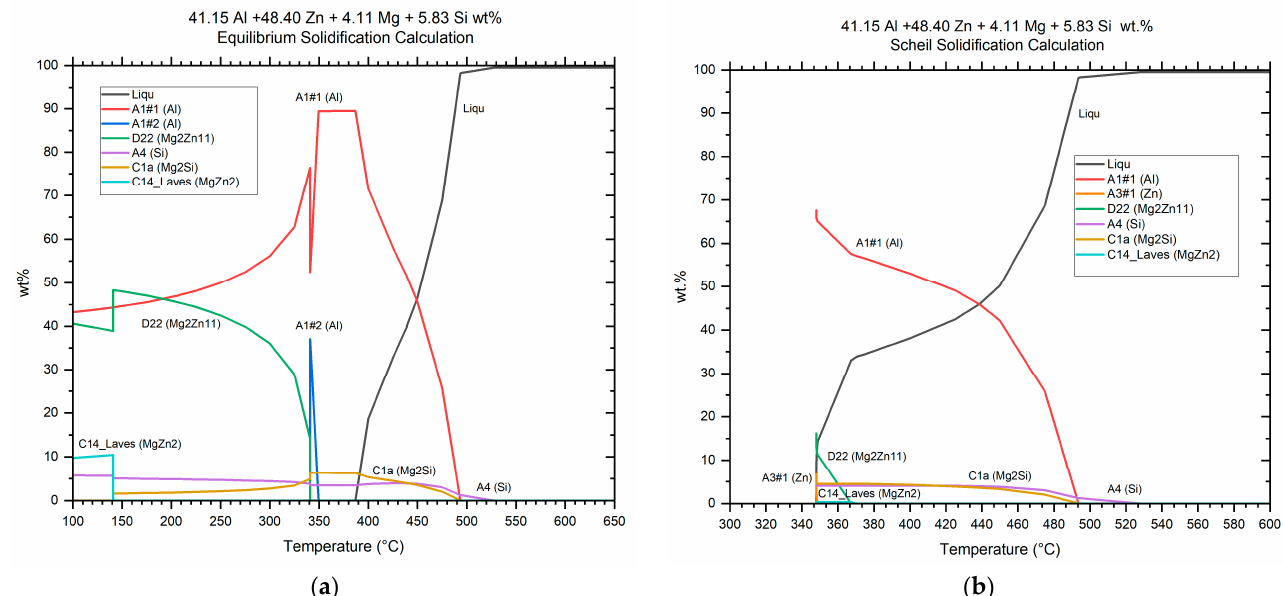
Figure 4. Thermodynamic simulations with FactSage for the studied alloy considering ( a ) equilibrium solidification conditions and ( b ) non-equilibrium solidification (Scheil model).